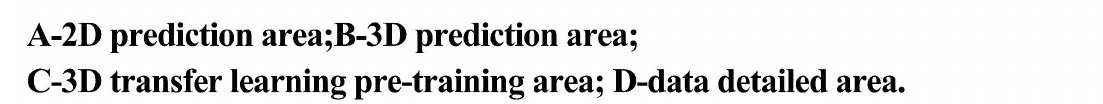
Figure 1. The regional geological and mineral map and district plan at a scale of 1:200,000. ( A ) represents the Songtao–Huayuan area; ( B ) represents the Huayuan Mining area; ( C ) represents the transfer learning pre-training area (Minle); and ( D ) represents the area with detailed data (according to the Hunan Bureau of Geology and Mineral Exploration and Development).